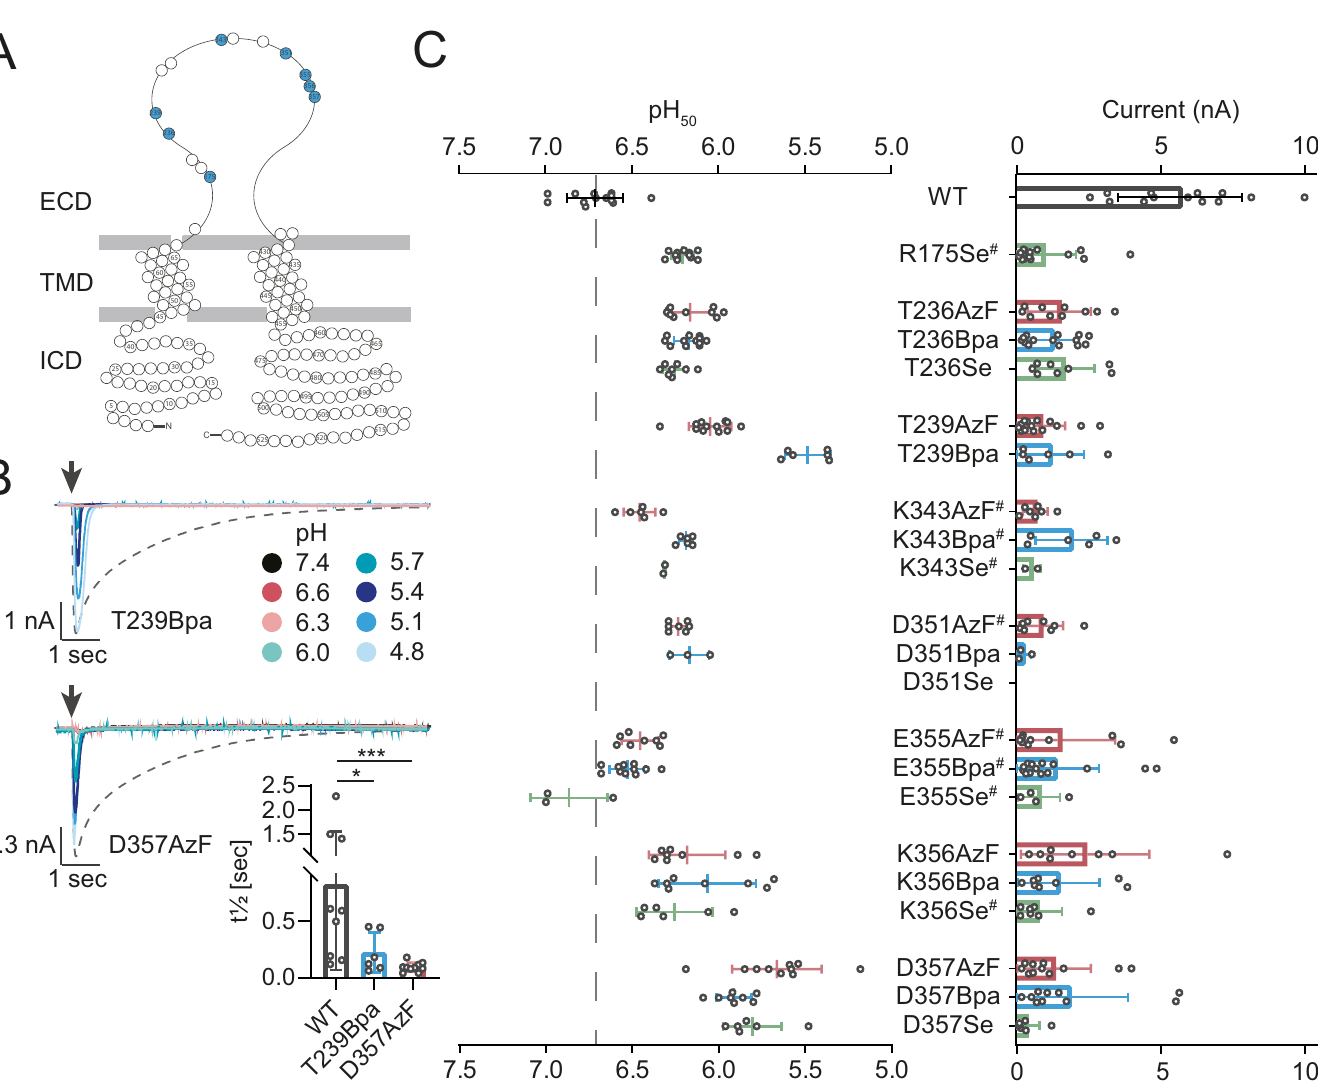
Fig 3. Incorporation of ncAA photocrosslinkers into the acidic pocket results in channel variants with lowered proton sensitivity and accelerated current decay. (A) Snake plot of hASIC1a with the assessed positions highlighted in blue. (B) Representative current traces of variants T239Bpa and D357AzF as recorded on the SyncroPatch 384PE, with arrows indicating the time of the proton application. Dashed lines indicate WT current in response to pH 6.0 application. Bar graph shows mean t ½ ± SD of current decay. (C) Incorporation of AzF (red), Bpa (blue), and Se-AbK (green) at 8 positions around the acidic pocket results in lowered proton sensitivity for several variants. Dot plots comparing pH 50 (left) and peak current sizes (right); bars indicate mean ± SD, ( # ) indicates > 20% tachyphylaxis (see also S8 Fig and S1 Table), and ( � ) denotes significant difference between t ½ of current decay, p < 0.05; ( ��� ): p < 0.001; Mann–Whitney test (see also S3 Table). The underlying data have been deposited at zenodo.org (https://doi.org/10.5281/zenodo.4906985; files 09, 10, and 33). AzF, 4-Azido-l-phenylalanine; Bpa, 4-Benzoyl-l-phenylalanine; ECD, extracellular domain; hASIC1a, human acid-sensing ion channel 1a; ICD, intracellular domain; ncAA, noncanonical amino acid; SD, standard deviation; Se-AbK,